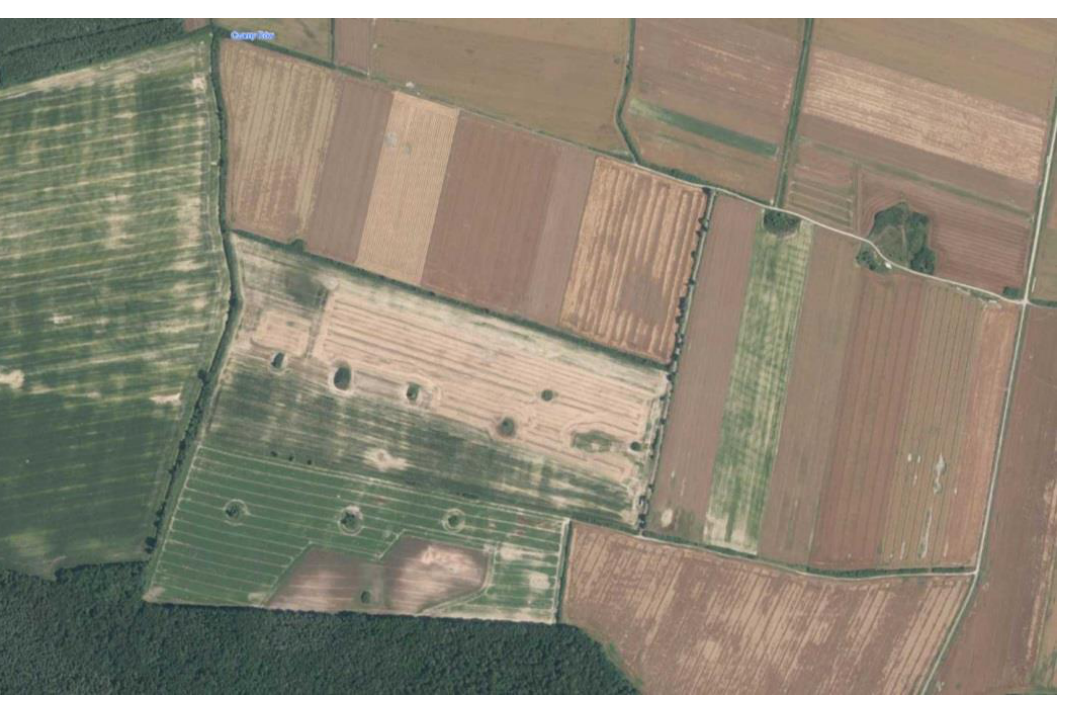
Figure 9: PMH as stepping stones – an example from the surroundings of Potarzyca village Source: geoportal.gov.pl,